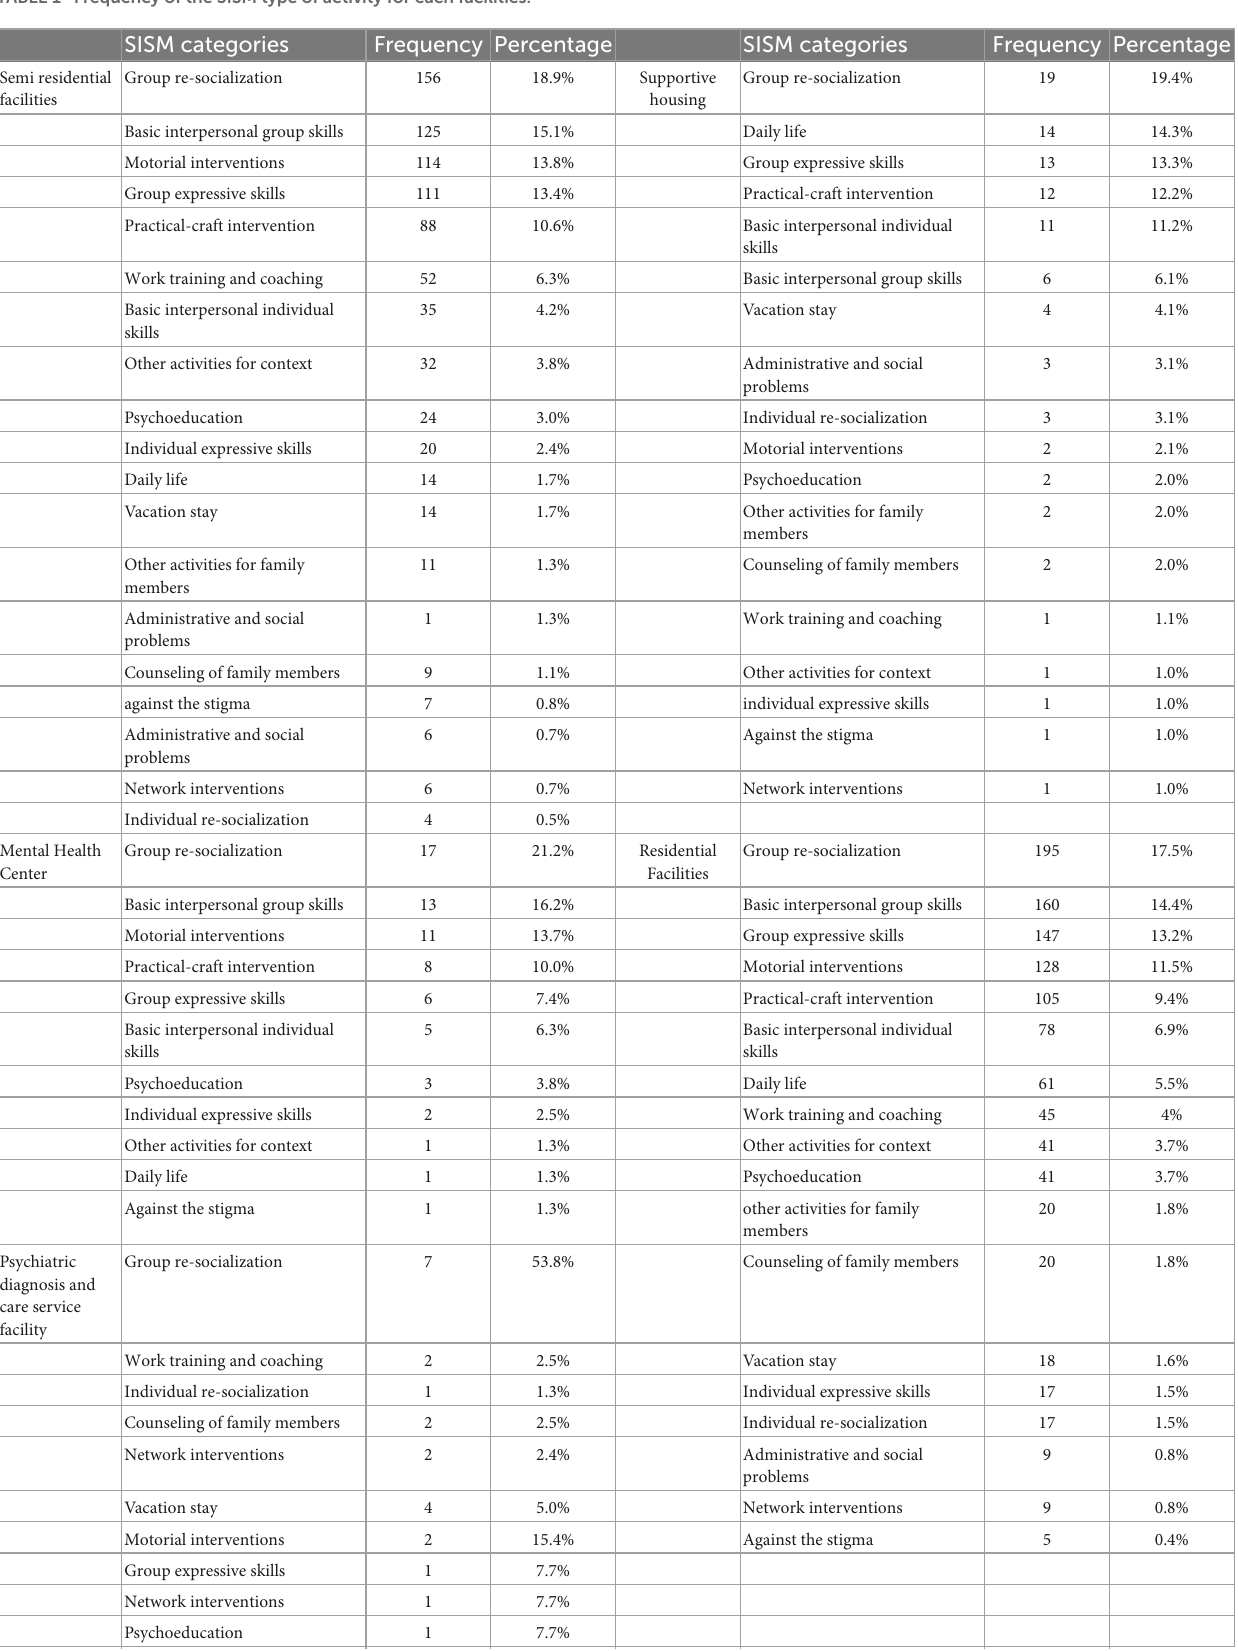
TABLE 1 Frequency of the SISM type of activity for each